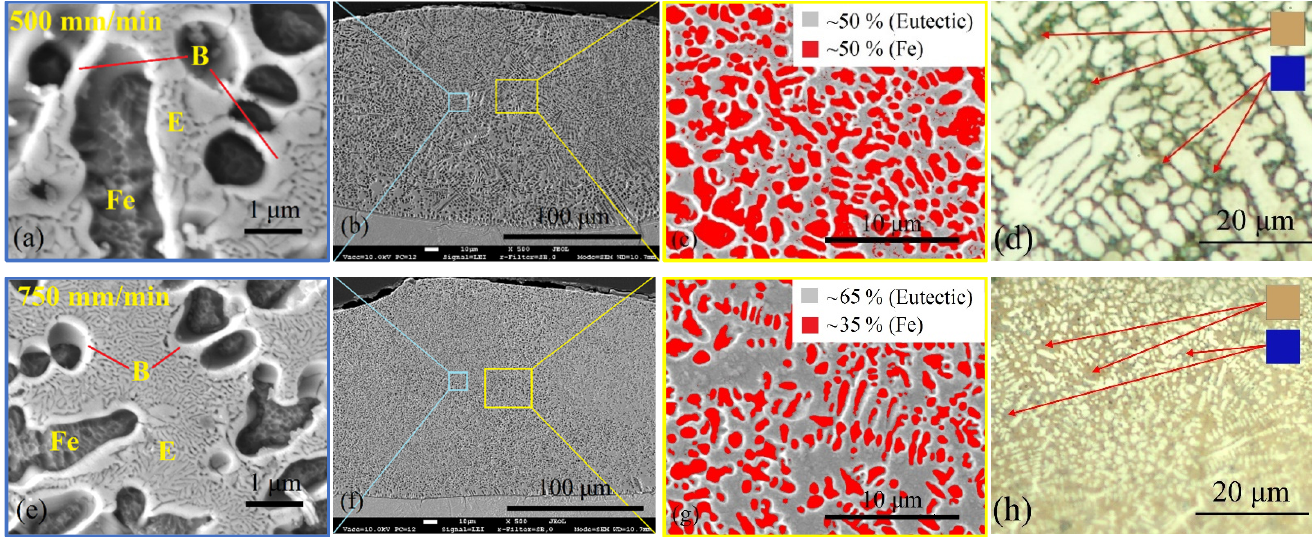
Figure 9. Hypoeutectic microstructure of the layers laser-boronized at 500 ( a – d ) and 750 ( e – h ) mm/min laser operating speed; ( a , b ): Fe-based solid solution dendrites (Fe) surrounded by the boride shell (B) that separates them from the eutectic phase (E); ( b , f )–general view of the melt pool with denoted areas of images ( a , c , e , g ); ( c , g )–micrographs processed with Scion Image program to assess the volume ratio of eutectic and solid solution phases; ( d , h )–optical micrographs of microstructure after etching with sodium picrate, which typically colors FeB borides in blue and Fe 2 B borides in brown.